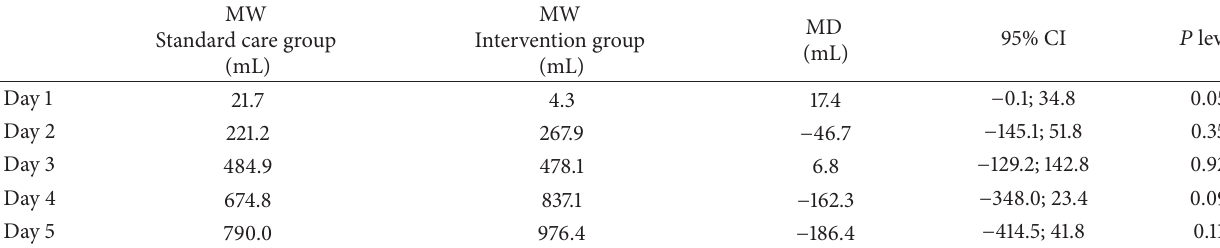
Table 5: Daily amount of given enteral nutrition.